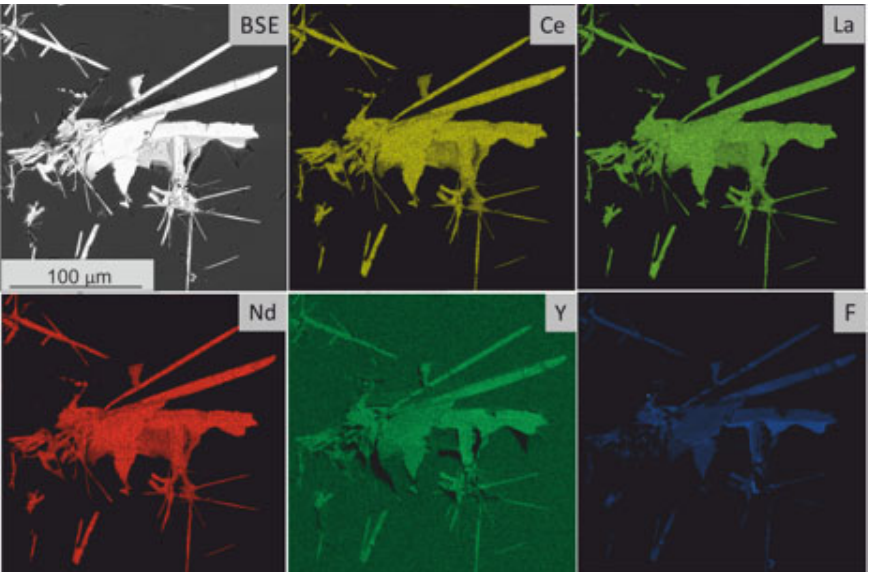
Figure 9. Back ‐ scattered electron (BSE) images and areal distribution of Ca, Ce, La, Nd, Y and F